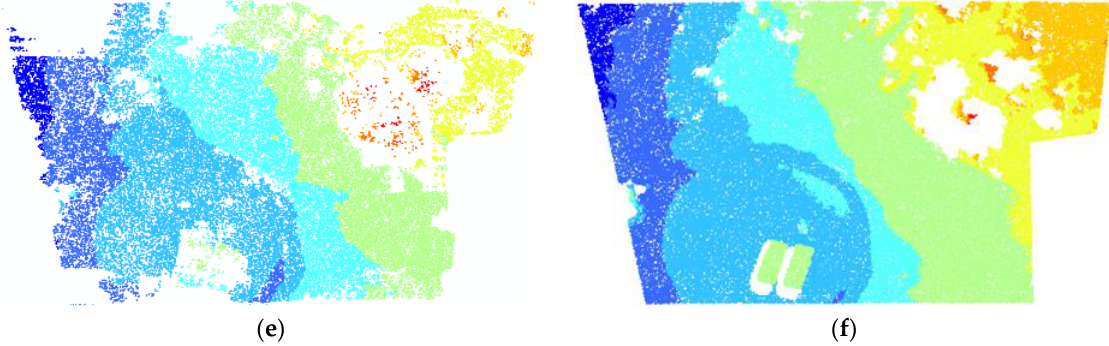
Figure 9. The generated dense point clouds based on the proposed procedure (( a ), ( b ), and ( c )) and Agisoft (( d ), ( e ), and ( f )) from the first, second, and third datasets. For a better visualization of the difference between the generated dense point clouds, we subtracted the corresponding point clouds using CloudCompare v2.9.alpha (64-bit) software (Électricité de France, Paris, France) based on the Iterative Closest Point (ICP) method. This comparison could also be used to show the elevation differences between two point clouds. Since both dense point clouds are generated using the same images, this difference is used to highlight the areas that are modeled based on the proposed method but not with Agisoft. In Figure 10, similar areas are demonstrated in blue. The visual comparison of both point clouds shows that they match with high percentages in most areas (blue dots in Figure 10). The most significant difference between the two point clouds can be observed in forestry areas, where some single trees were detected in the proposed method but not in the Agisoft point cloud (shown in green, yellow, and red dots in Figure 10).